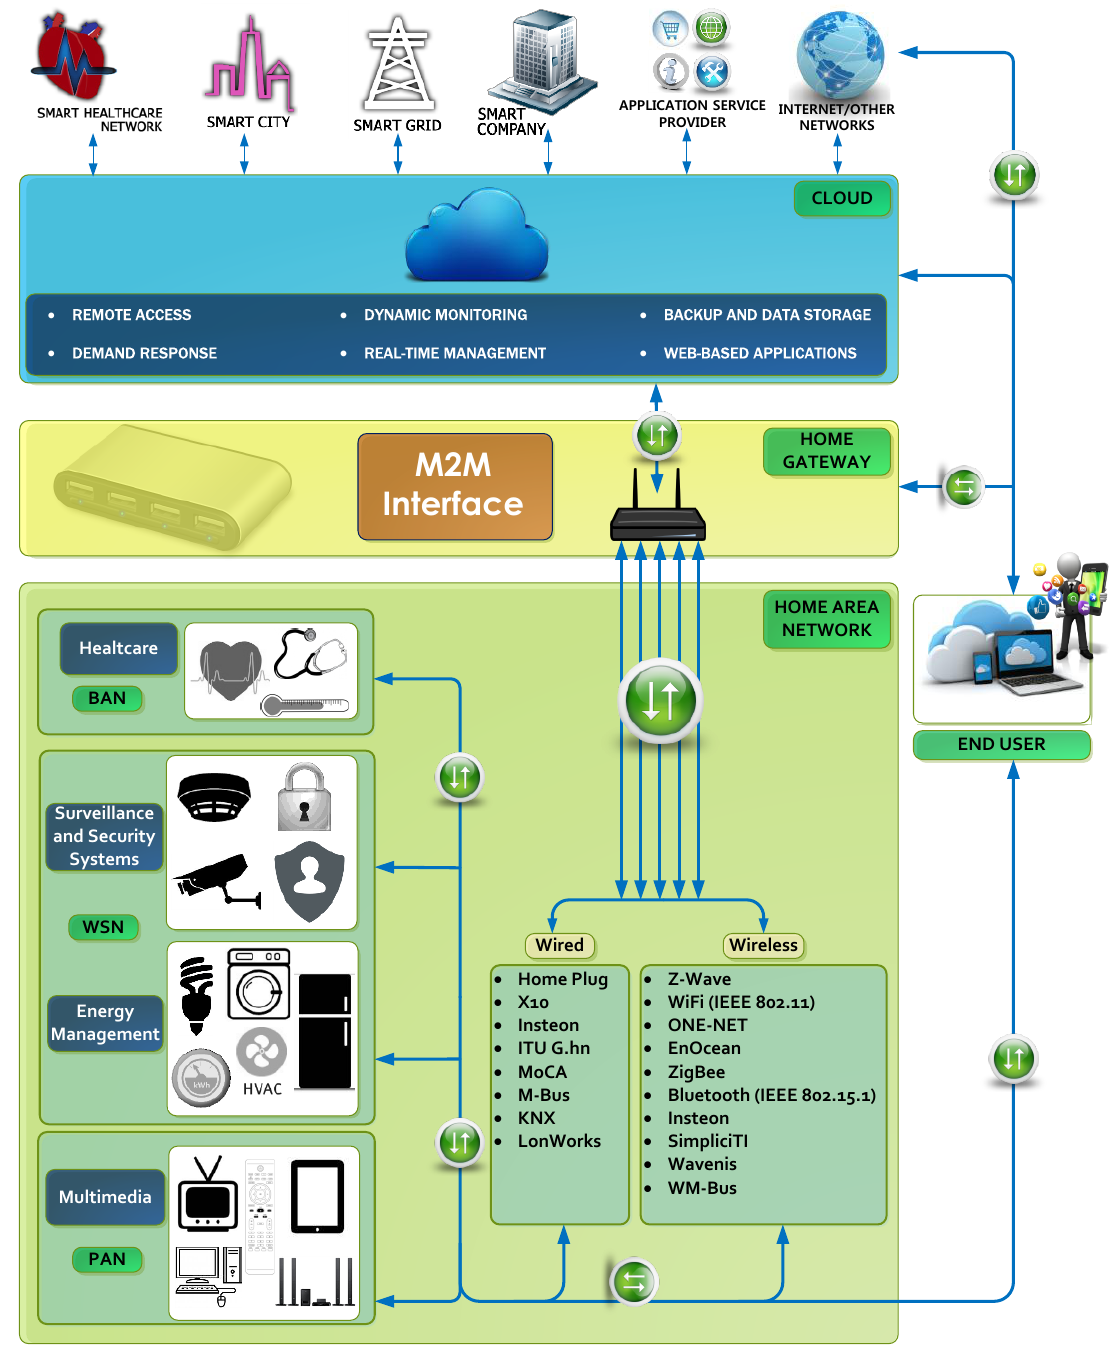
Figure 1. Smart home devices accessed through global network